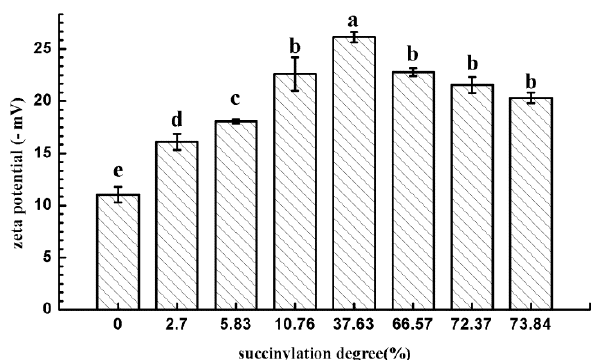
Figure 7. Changes in the zeta potential of EWP and SEWP (mean ± SD, n = 3). The different letters (a–e) above the columns indicate significant differences ( p < 0.05) among the samples treated according to different succinylation degrees.